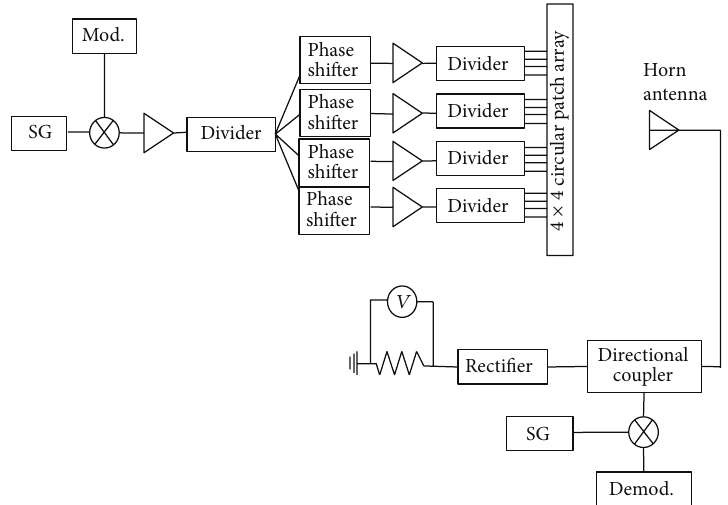
Figure 7: Block diagram of the experimental demonstration of the WiCoPT technology with beam steering.